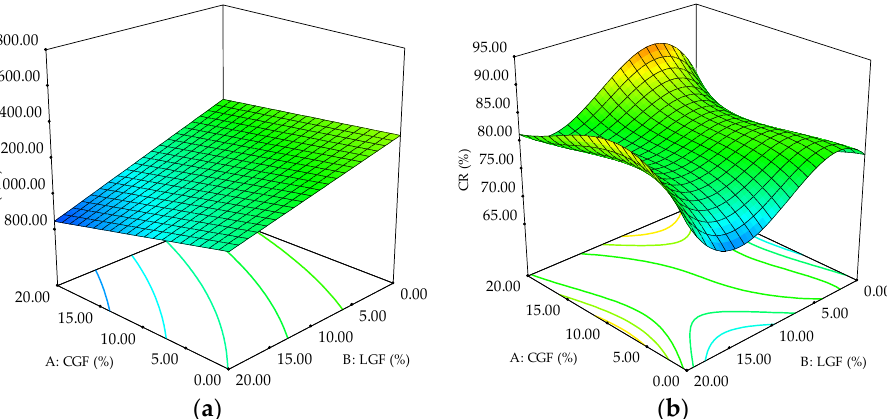
Figure 7. Response surface plot of ( a ) volume of the gas retained in the dough at the end of the test